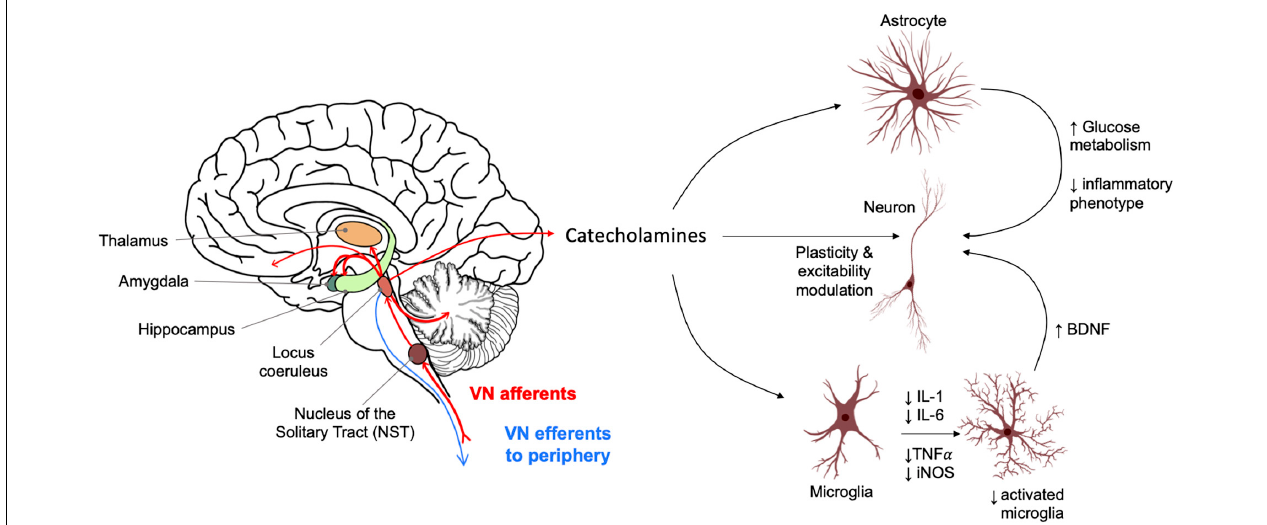
FIGURE 1 | Vagus nerve afferent activity causes catecholamine release from the locus coeruleus into widespread brain regions. These include areas relevant for memory and highly impacted in Alzheimer’s disease such as the hippocampus. Norepinephrine (NE) acts on astrocytes and neuroglia, influencing an anti-inflammatory profile and neurotrophic support for neurons. NE also acts directly on neuronal populations to modulate synaptic plasticity and function with distinct effects depending on brain regions and neuron sub-types. LC activation also causes release of dopamine in the hippocampus which modulates neuronal plasticity and excitability and has a role in the consolidation of “everyday” type